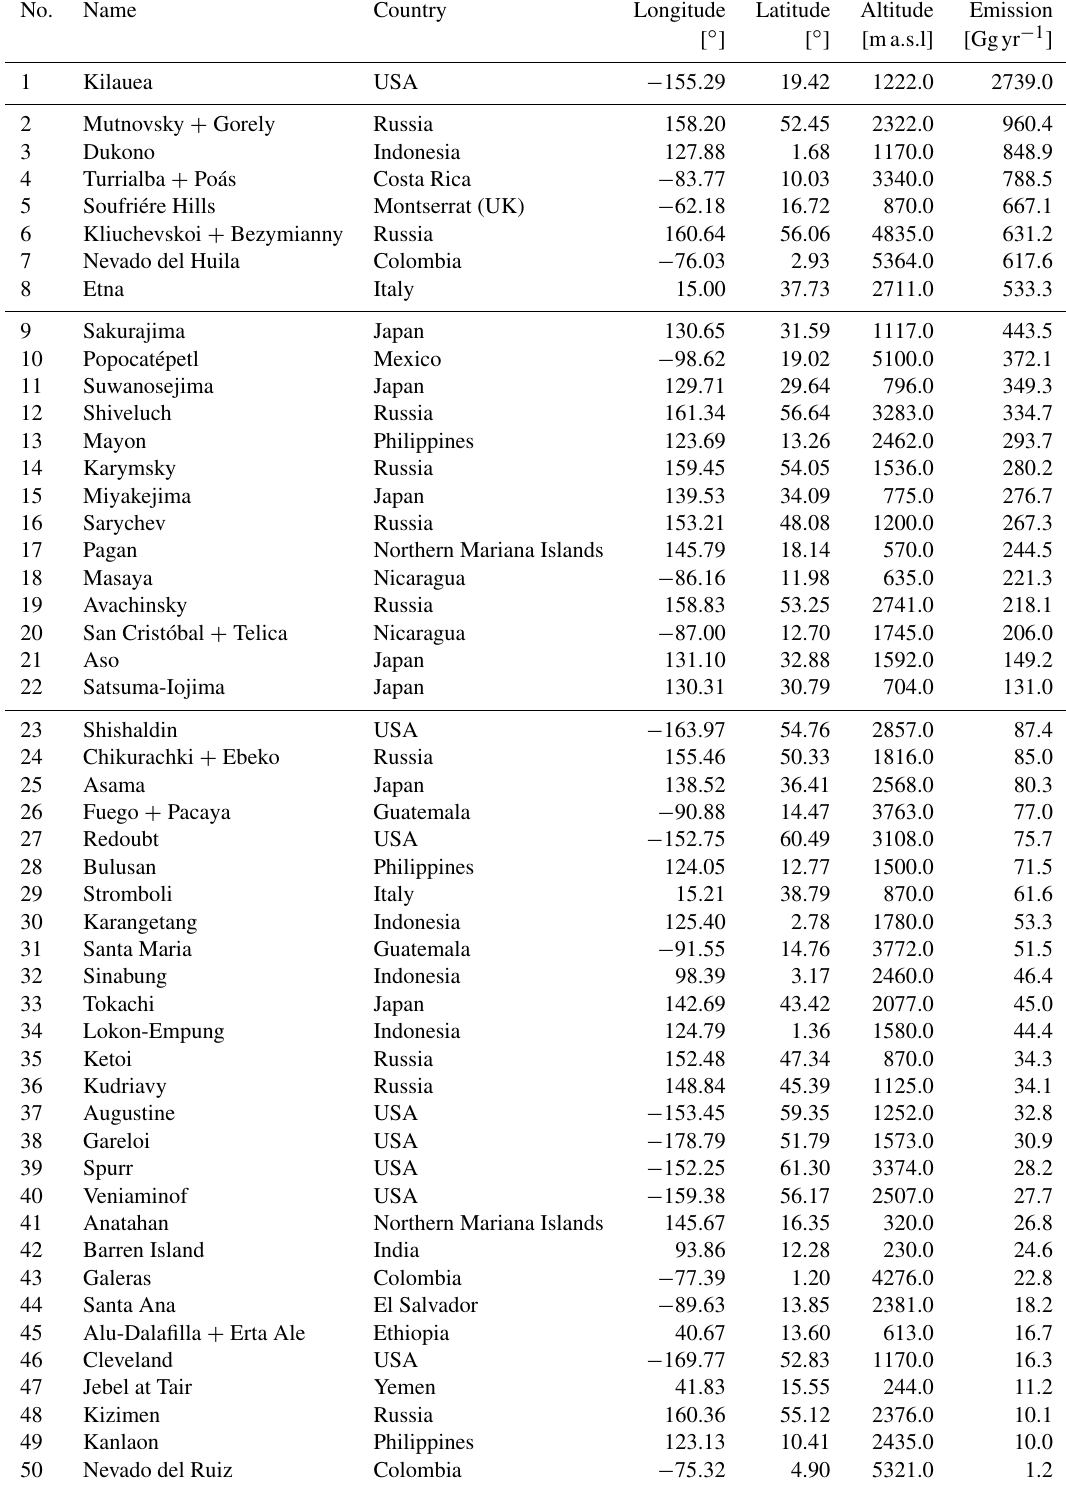
Table 1. Information of volcanoes incorporated in this study.